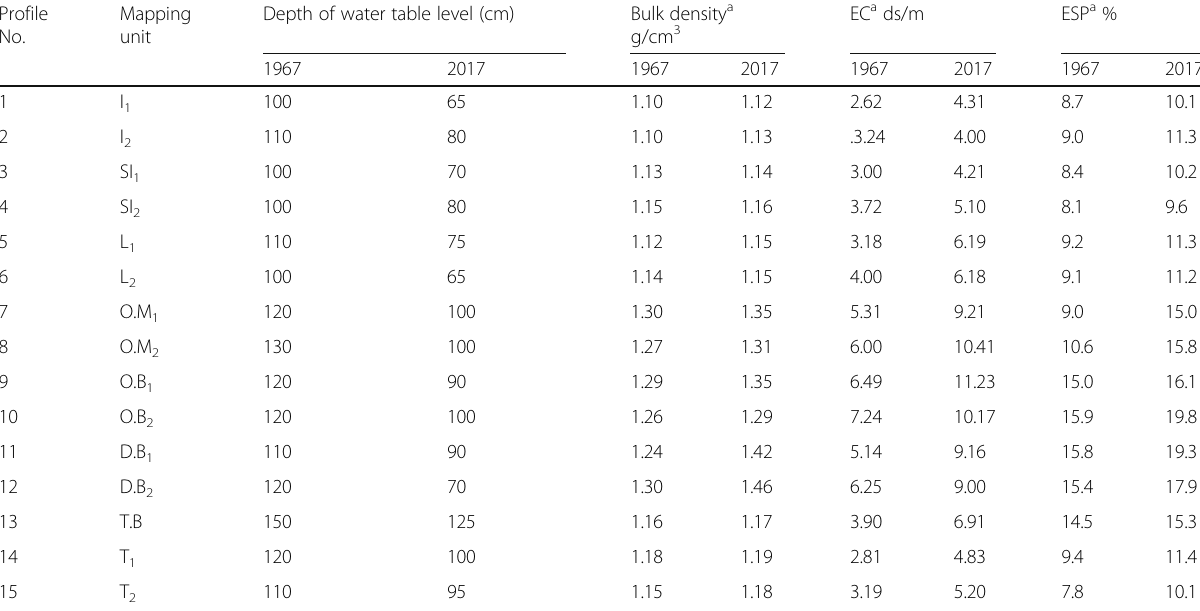
Table 9 Changes of the main land characteristics Profile No.